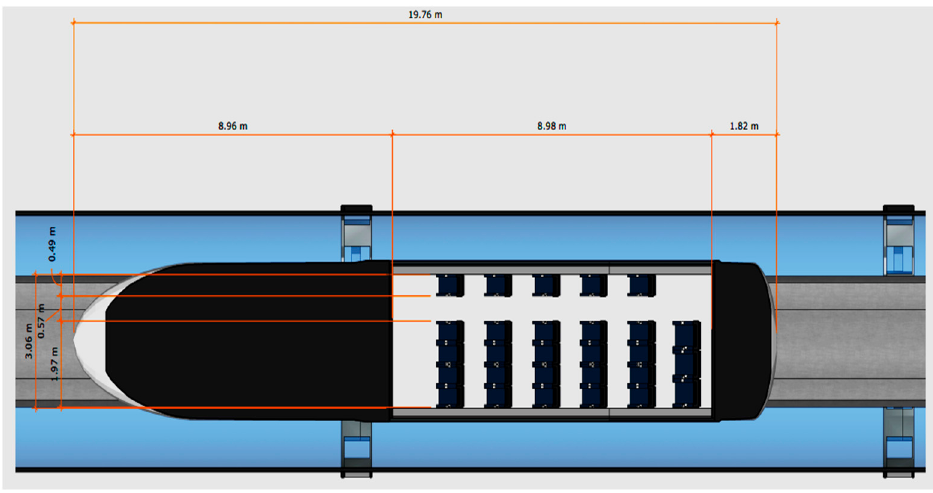
Figure 1. Low-capacity capsule.